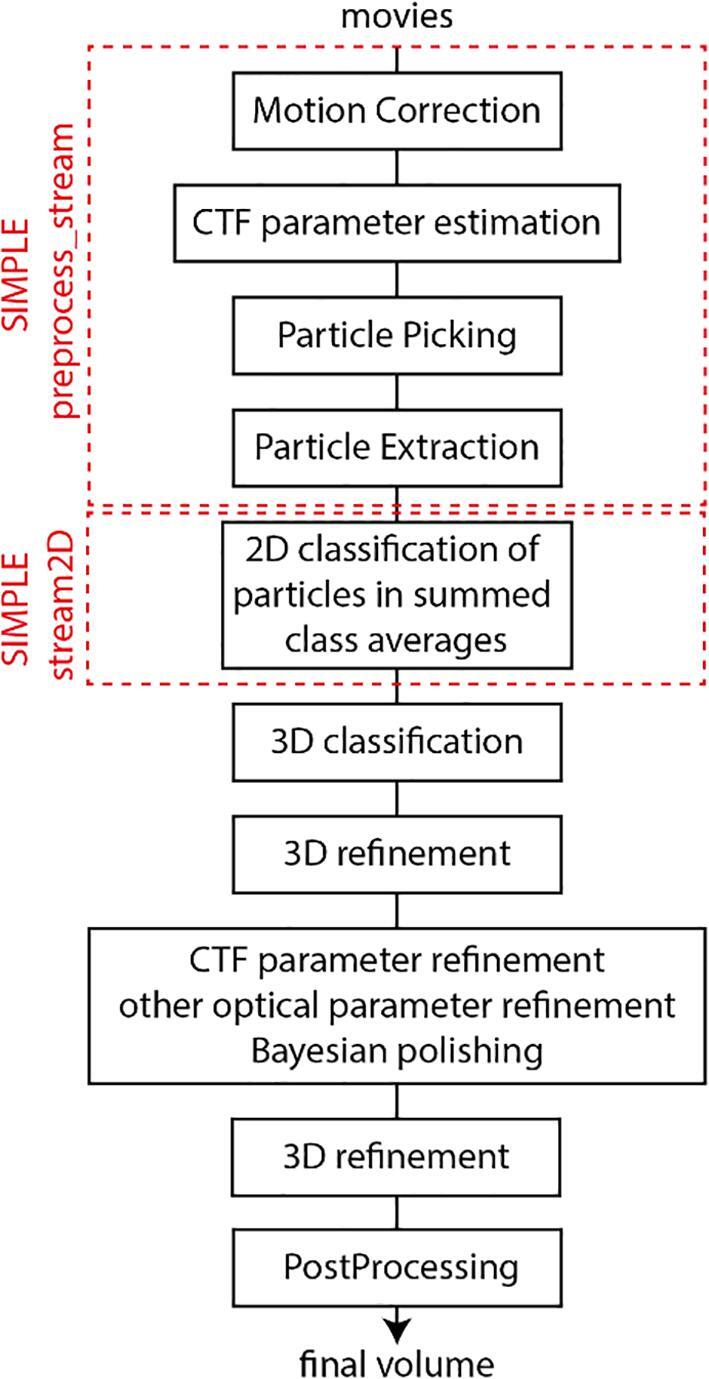
Schematic overview of steps in SPA.